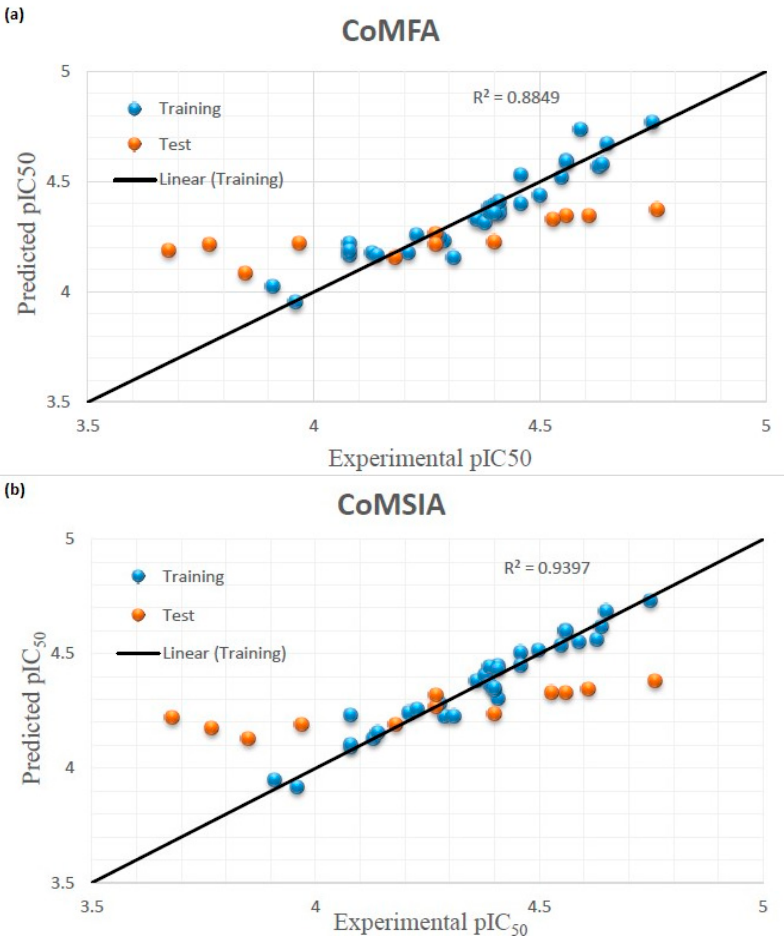
Figure 2. Graphical interpretation of experimental vs. predicted pIC 50 of compounds 1 – 44 developed by CoMFA ( a ) and CoMSIA ( b ) models.